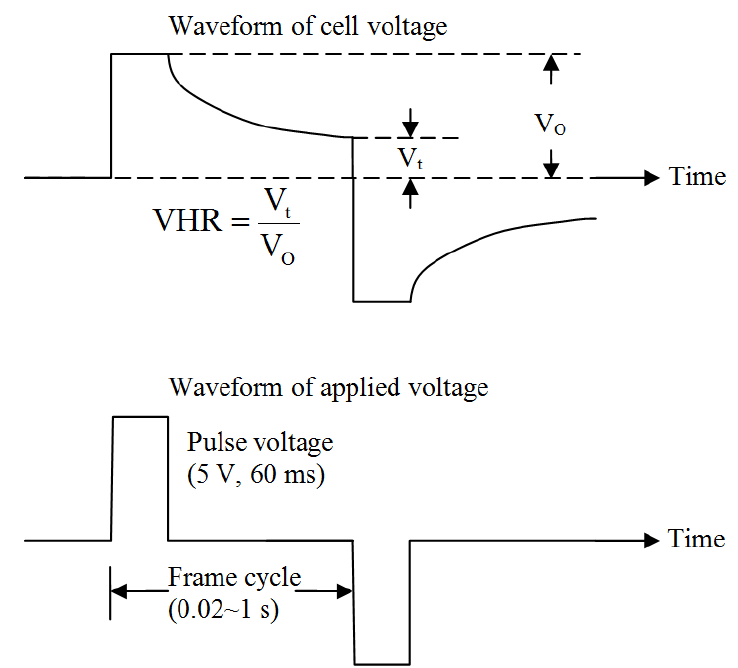
Figure 4. Waveforms for applied pulse voltage in voltage holding ratio (VHR) and the response waveform by the test